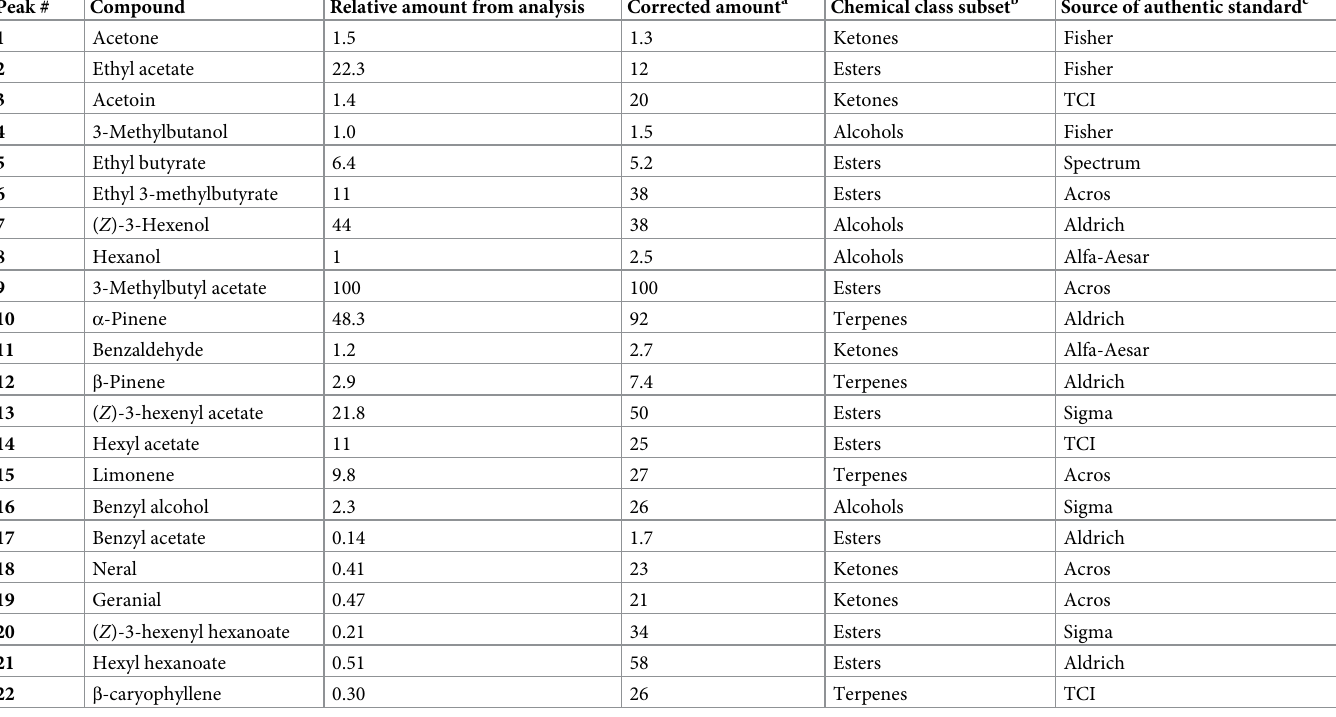
Table 1. Compounds identified from commercial papaya-flavored oil by solid phase microextraction followed by analysis by gas chromatography-mass spectrome- try. Amounts are normalized to the most abundant compound, 3-methylbutyl acetate, in the